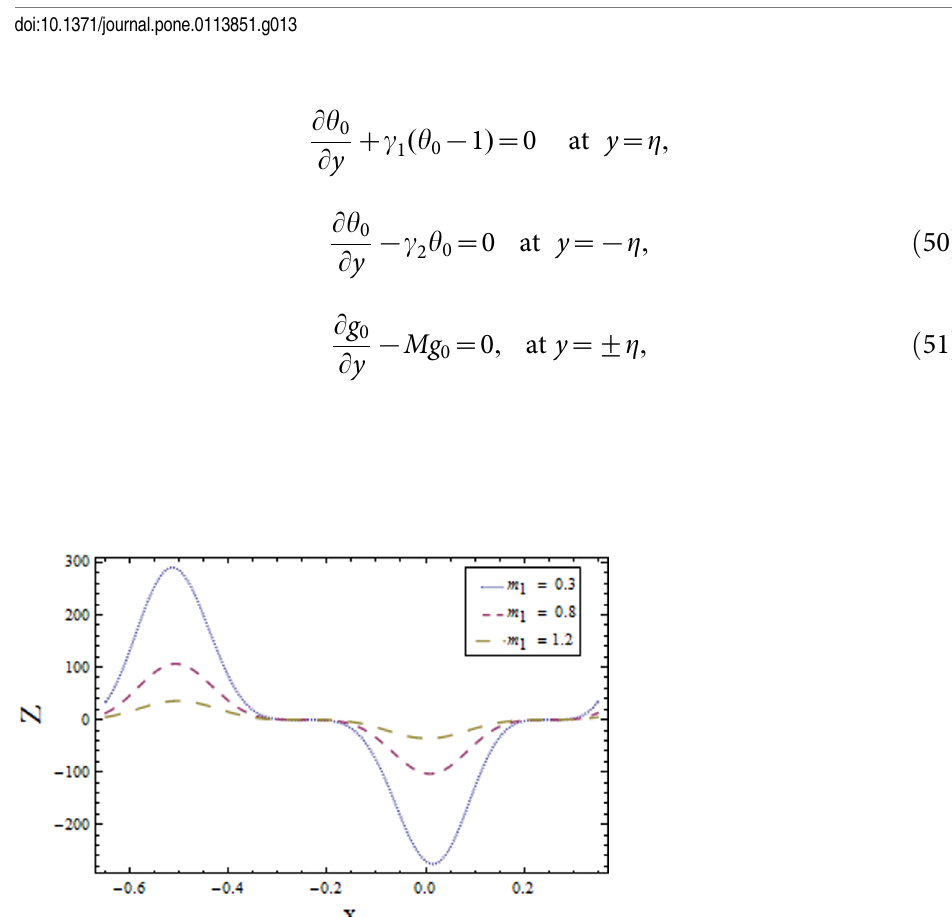
Figure 13. Plot of heat transfer coefficient Z for Hall parameter m with E ~ 0 : 1 , t ~ 0 : 01 , ª 1 ~ 4 , ª 2 ~ 6 , E